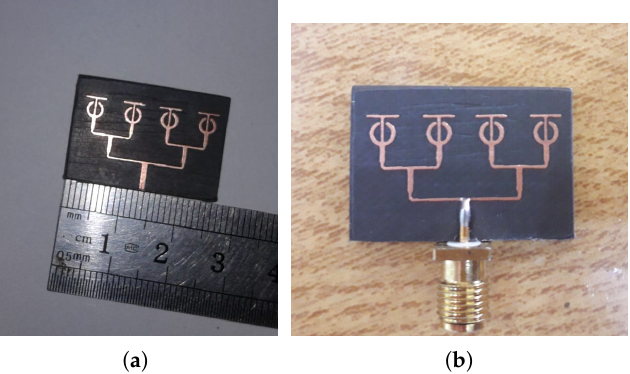
Figure 6. Fabricated prototype of proposed antenna design: ( a ) with scale; and ( b ) without scale.